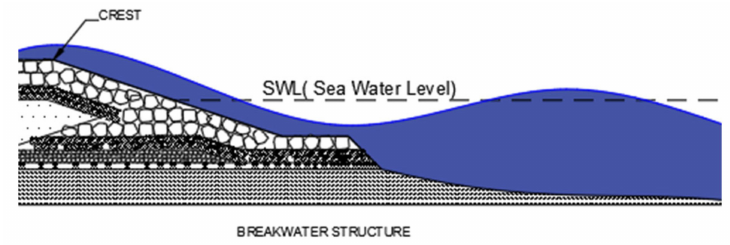
Figure 1. General diagram of overtopping waves.